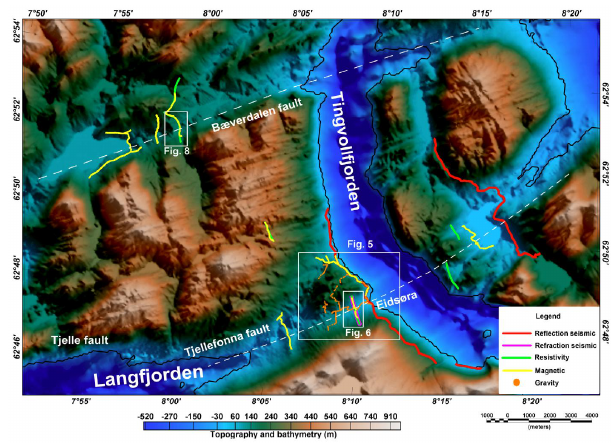
Fig. 3. Several geophysical datasets have been acquired in the study area (blue box in Fig. (1). The background map depicts topogra- phy and bathymetry. The white boxes outline geophysical profiles whose corresponding results are shown in Figs. 5, 6 and 8. Dashed white lines show the proposed Tjellefonna and Bverdalen